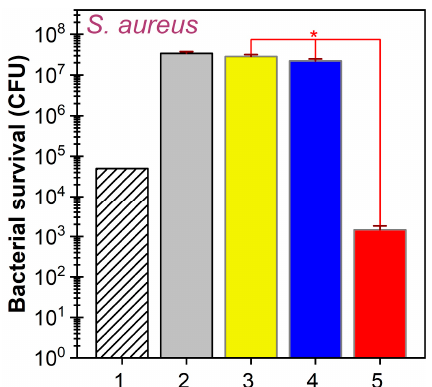
Figure 8. Antibacterial activity against S. aureus at 24 h. The data are presented in logarithmic values of CFUs (bacterial survival). (1) seeded CFUs; (2) control = nutrient broth without sample; (3) bare and silica-rich (4) FastOs ® BG and (5) Cu&Ga-FastOs ® BG coated substrate. * p < 0.05, statistically significant differences, as determined by using an unpaired two-tailed Student’s t -test.